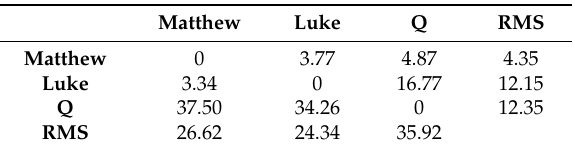
Table 14. Own Tradition and Q. Kolmogorov–Smirnov test results for P F (below the diagonal of zeros) and C P (above the diagonal). The values reported are the confidence level (%) that the indicated couple of probability distributions are not